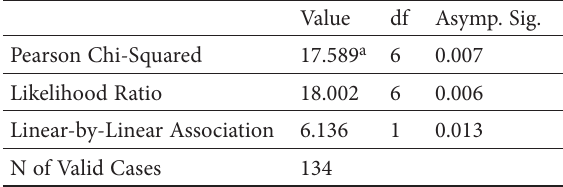
Table 2. Captain Top 2008. Chi-Square tests by type of airline